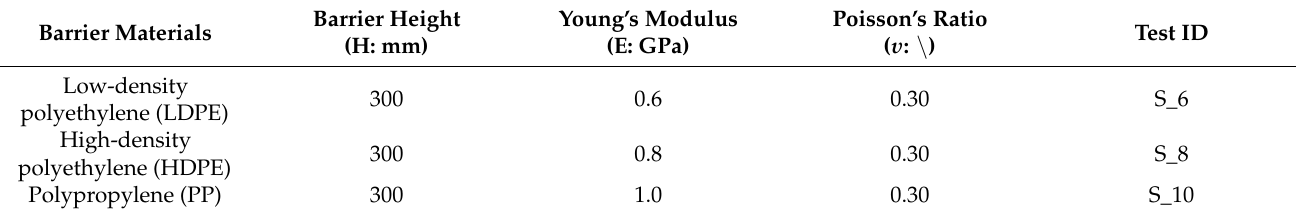
Table 1. Characteristics of